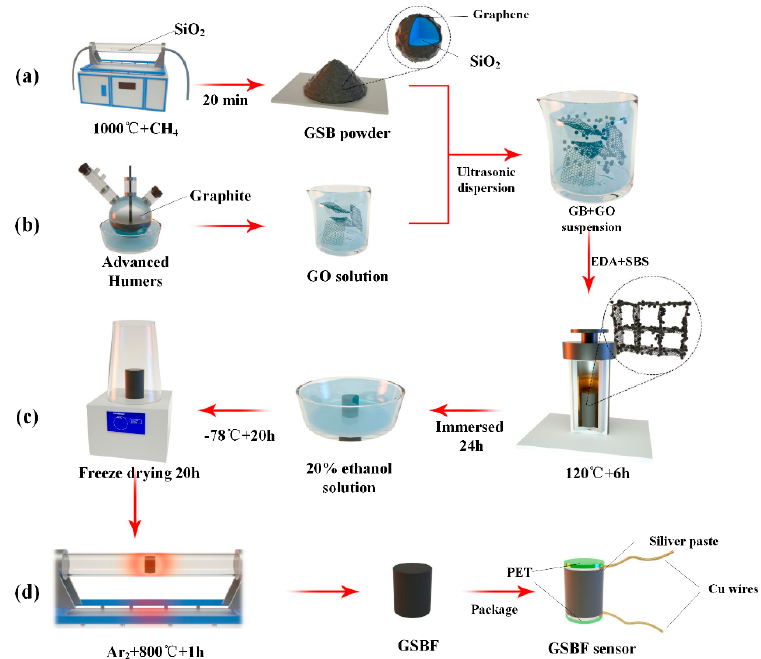
Figure 1. The schematic illustration of synthesis process of three-dimensional graphene composite foam (GSBF) composite and GSBF sensor. ( a ) synthesis of graphene-SiO2 balls (GSB). ( b ) preparation of graphene oxide (GO) solution. ( c , d ) the preparation process of GSBF and GSBF